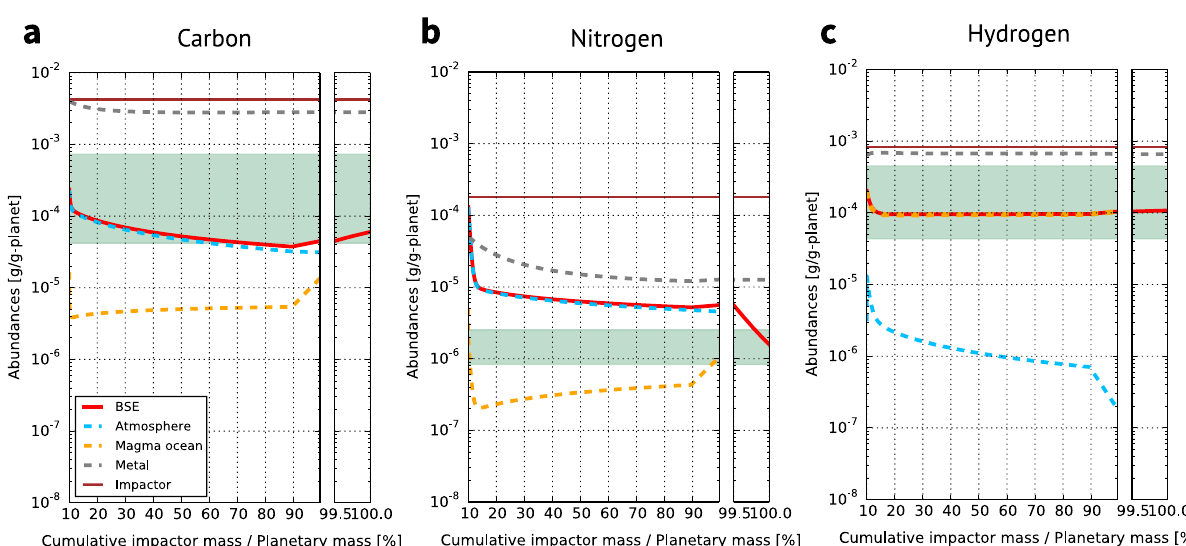
Figure 3. Evolution of the abundances of C, N, and H in the surface and interior reservoirs over the full accretion obtained from the nominal model. Dashed lines correspond to the amounts in the atmosphere (light- blue), magma ocean (orange), and metallic core (grey) for the main accretion phase and in the surface reservoirs (the atmosphere, oceans, and carbonate rocks: red solid line) for the late accretion phase. Solid lines mean the net cumulated into the bulk silicate Earth (BSE; red) and delivered by impactors (brown). The green areas denote the amounts in the current BSE. Plotted abundances are scaled by the planetary mass at a given